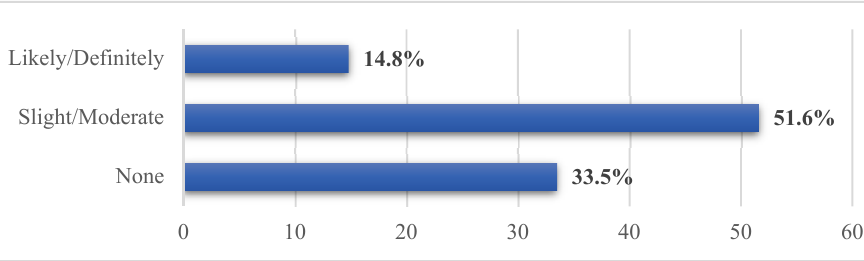
Figure 1. Use of EHR associated features during COVID 19 among participants. Table 1. Participants’ demographic and professional characteristics (N = 182).